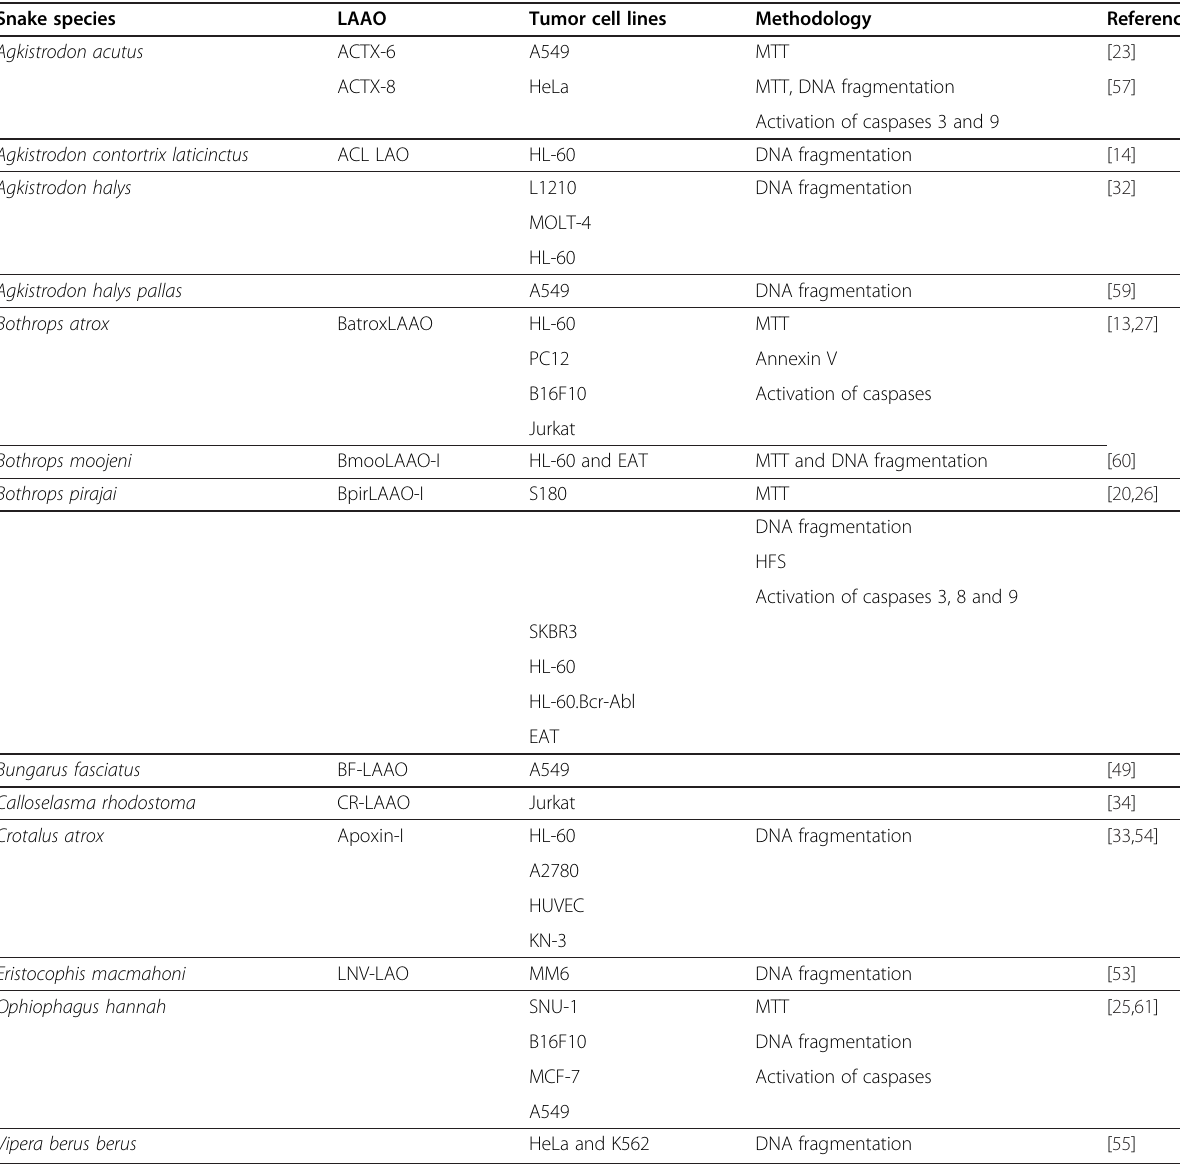
Table 1 Summary of some SV-LAAOs and the tumor cell lines in which they were tested Snake species LAAO Tumor cell lines